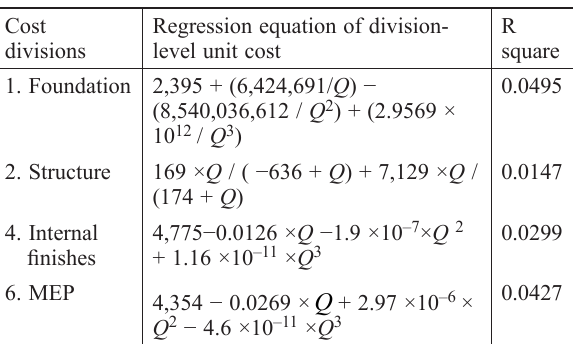
Table 2. Regression equations of division-level unit costs